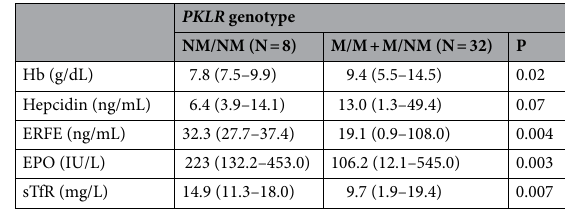
Table 3. Iron homeostasis biomarkers in PKD patients grouped according to PKLR genotype. Values are expressed as median (range). NM non-missense variant, M missense variant. Mann–Whitney